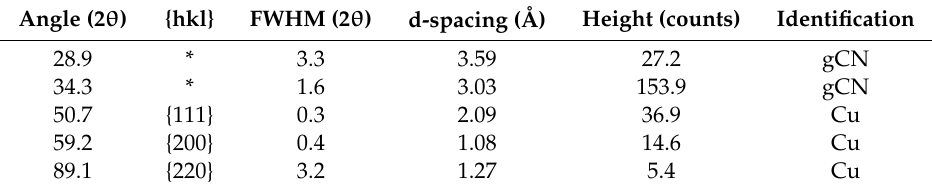
( d ) Figure 4. TEM images of Cu NPs embedded in the amorphous gCN support. ( a ) Low-resolution image obtained using a Zeiss-EM10C-80 kV instrument; ( b ) and ( c ) High-resolution images obtained using a JEOL JEM2010-200 kV TEM. ( d ) Mean size (nm) and distribution by analysis of ≈ 40 Cu NPs.